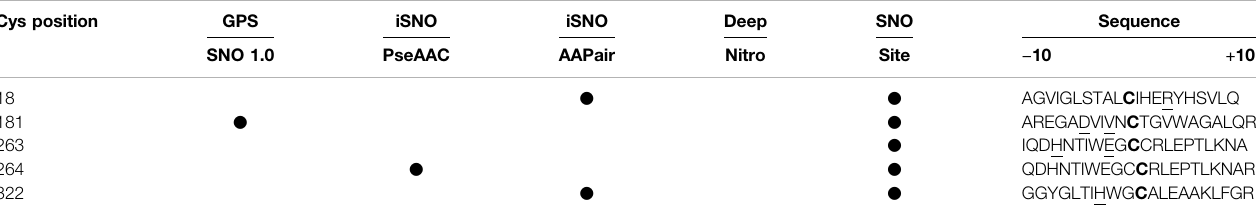
TABLE 1 | Prediction of nitrosylation sites by using web-based tools. Cysteine residues indicated in bold are strictly conserved in hDAAO. In the last column, underscored residues are those present in the consensus sequence of putative nitrosylation motifs as identi fi ed by the SNO site. Cys